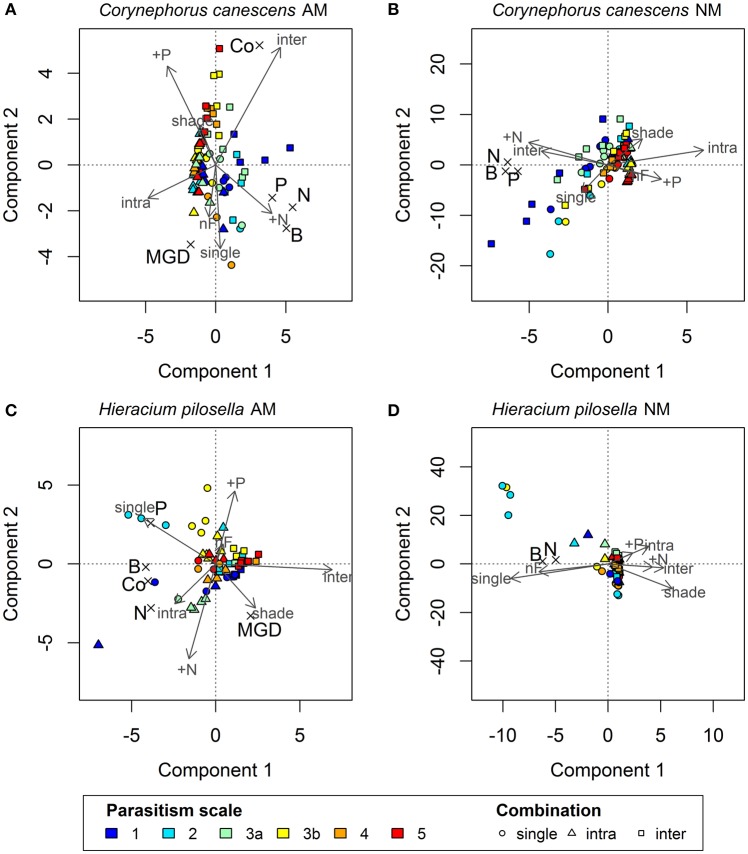
Biplots showing Y-scores and X- and Y-loadings of the first two components of Partial Least Squares (PLS) regression models for mycorrhizal (A) and non-mycorrhizal (B) plants of Corynephorus canescens and mycorrhizal (C) and non-mycorrhizal (D) plants of Hieracium pilosella. Symbols of sample scores are colored depending on assumed ranks of a theoretical scale of mycorrhizal parasitism potential, with blue to red indicating treatments with low to high parasitism potential. Symbol types refer to competition treatments, with dots indicating plants grown alone and triangles and squares indicating intra- and interspecific competition, respectively. Scaled X-loadings are represented by gray labeled arrows. Scaled Y-loadings are depicted by crosses with black letters in larger fond. For explained variance in Y please see Table 2. AM, mycorrhizal plants; NM, non-mycorrhizal plants. Independent variables (X): inter, intra, and single = interspecific, intraspecific competition and plants grown alone; shade = shade treatment; N, P, nF = nitrogen and phosphorus fertilization and no fertilization, respectively. Dependent variables (Y): MGD = mycorrhizal growth dependency; B = total biomass; Co = colonization; P = plant phosphorus content, N = plant nitrogen content.